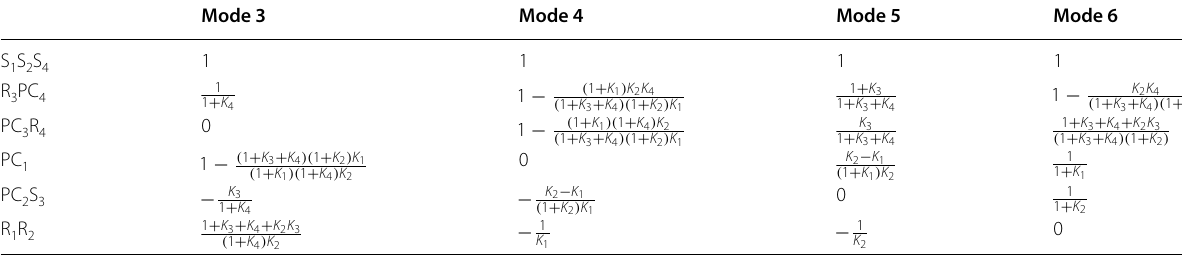
Table 3 Rotational speed of each component when A engaged (r/min) Mode